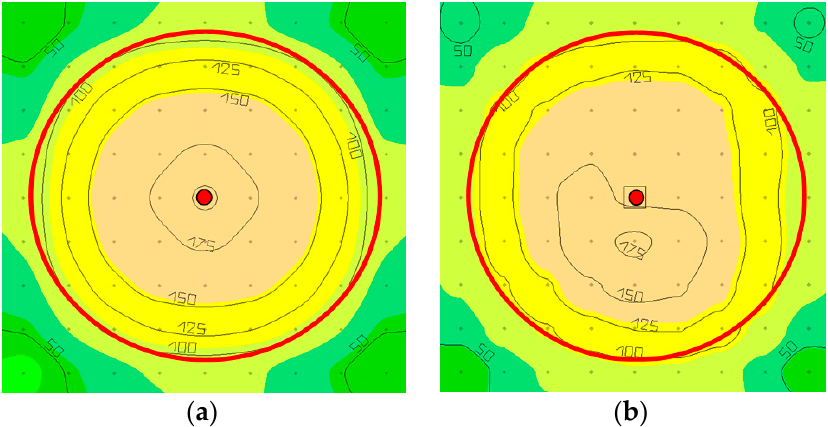
Figure 25. Illuminance distribution on a plane for wide symmetrical light distribution (128°): ( a ) results for a simulation model, ( b ) results for a prototype luminaire.